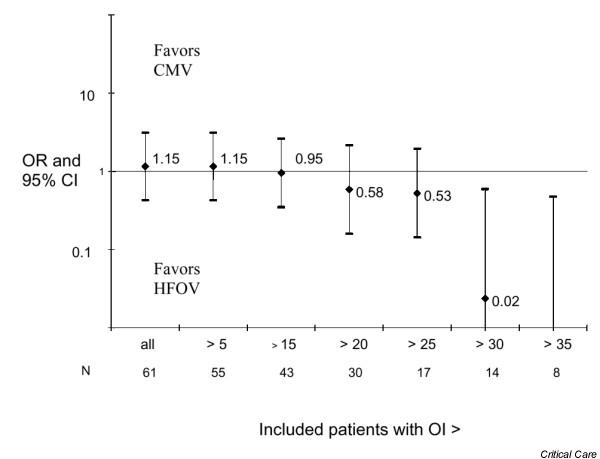
Post hoc analysis of the treatment effect on mortality relative to baseline oxygenation index (OI). On the y-axis the odds ratio of mortality (OR) adjusted for study site, OI, ventilatory index, APACHE II score, age and weight is presented by diamonds and 95% confidence intervals by bars. On the x-axis the different analyses are depicted including patients with increasing levels of initial OI at study entry. N denotes the number of patients in each subgroup. CI, confidence interval; CMV, conventional mechanical ventilation; HFOV, high frequency oscillatory ventilation.